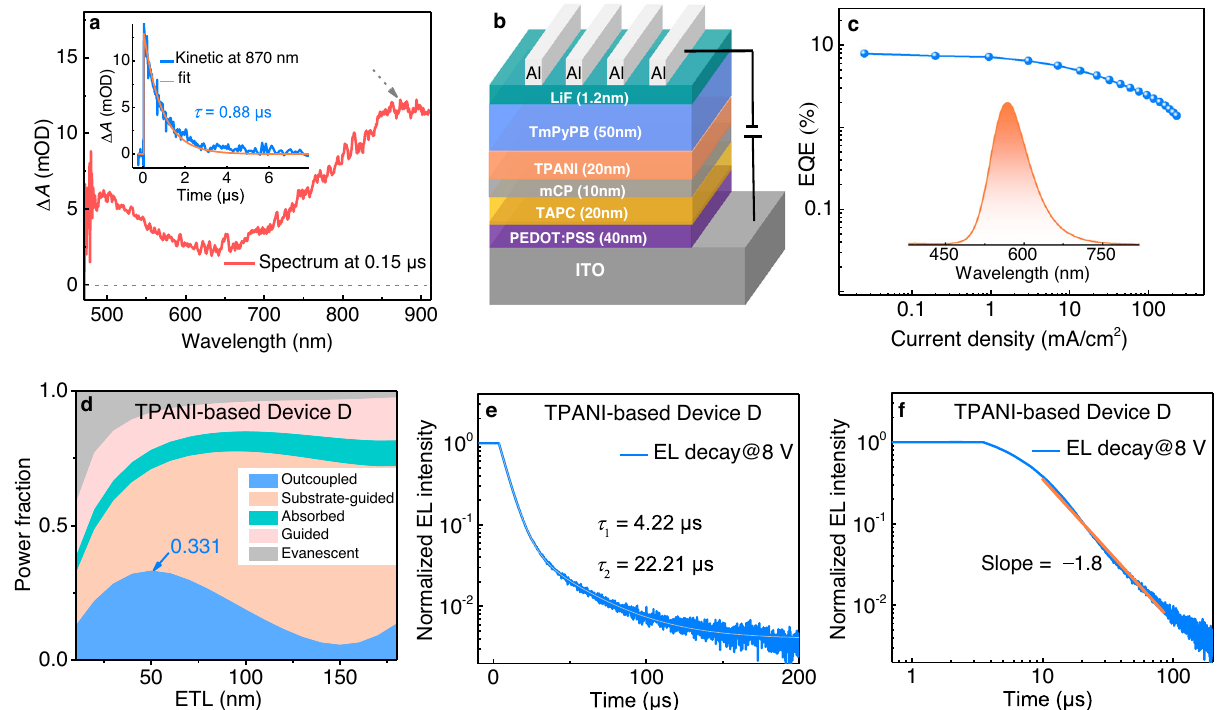
Fig. 6 | TA spectrum and EL characteristics. a ns-TA spectrum of TPANI in iodomethane under N 2 atmosphere at RT (5×10 − 4 M, λ ex =355nm, delayed time: 0.15 μ s, OD: optical density). Inset: TA decay pro fi le of TPANI at 870nm. b Device structure and c external quantum ef fi ciency (EQE) as a function of current density ( J ) for the TPANI-based optimal Device D. Inset: the EL spectrum of Device D